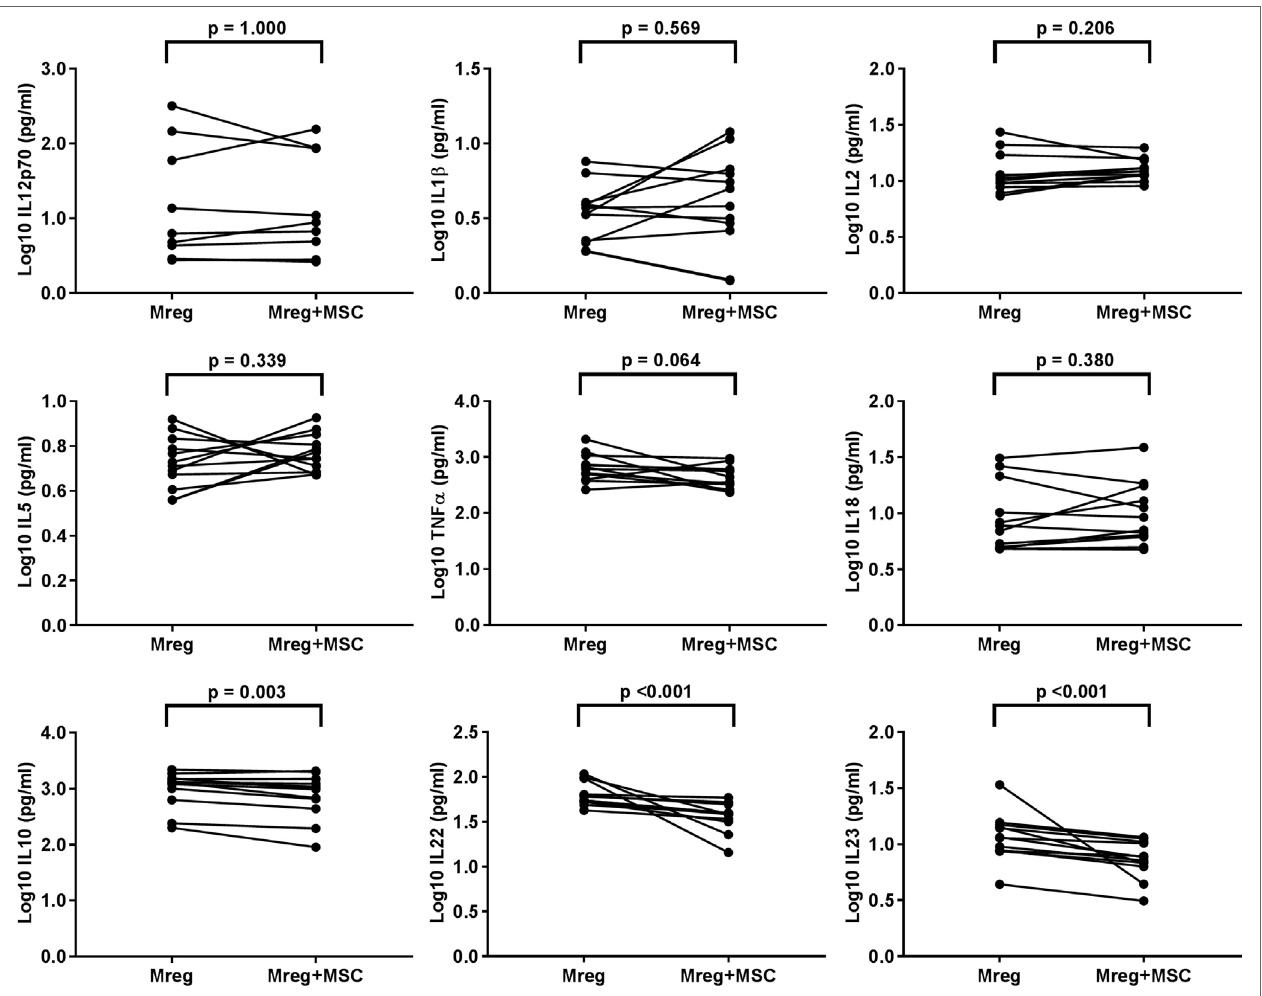
FigUre 3 | Effect of MSC coculture on the level of cytokines in Mreg-conditioned media. The media were analyzed for 18 cytokines and measures within the cytokine-specific detection range were included in the analysis. The values of cell culture media cytokines were log10-transformed. The variation of cytokines between Mreg-conditioned media with and without MSC coculture was analyzed by the Wilcoxon matched-pairs signed-rank test. The number of biological replicates varied from 9 to 12. Abbreviations: IL, interleukin; Mreg, regulatory macrophage; MSC, mesenchymal stromal